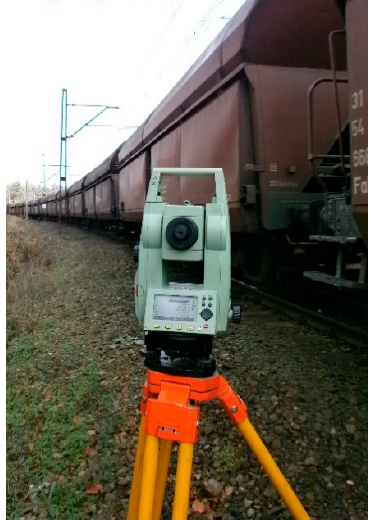
Figure 3. The electronic total station TC-407—measuring station.